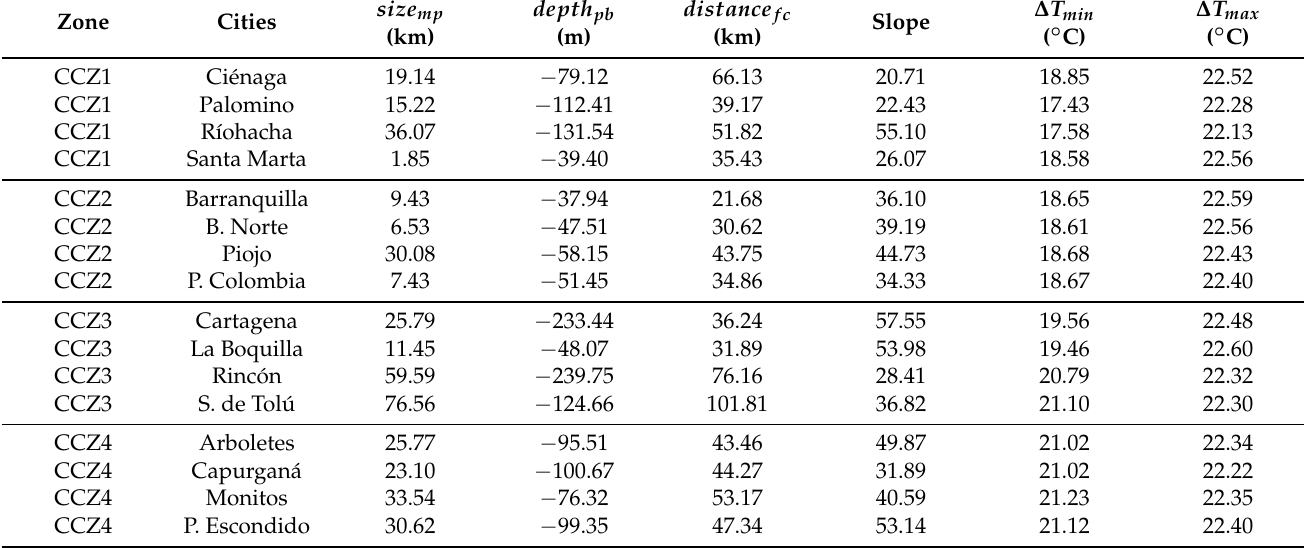
Table 1. Continental platform break at 16 points in the Colombian